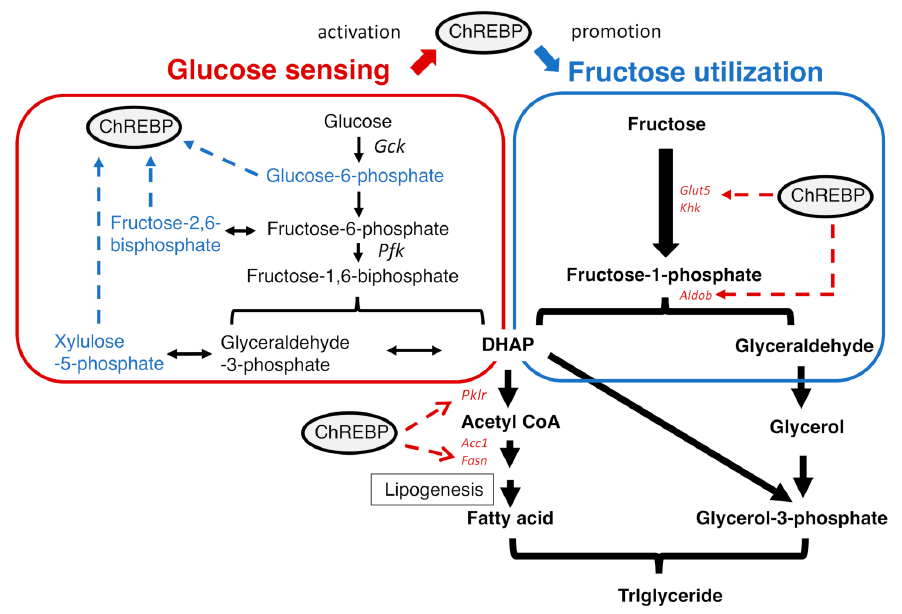
Figure 2. Glucose activates ChREBP, which then promotes fructolysis. Glucose increases the levels of metabolites that activate ChREBP. Upon activation, ChREBP induces fructolytic and lipogenic gene